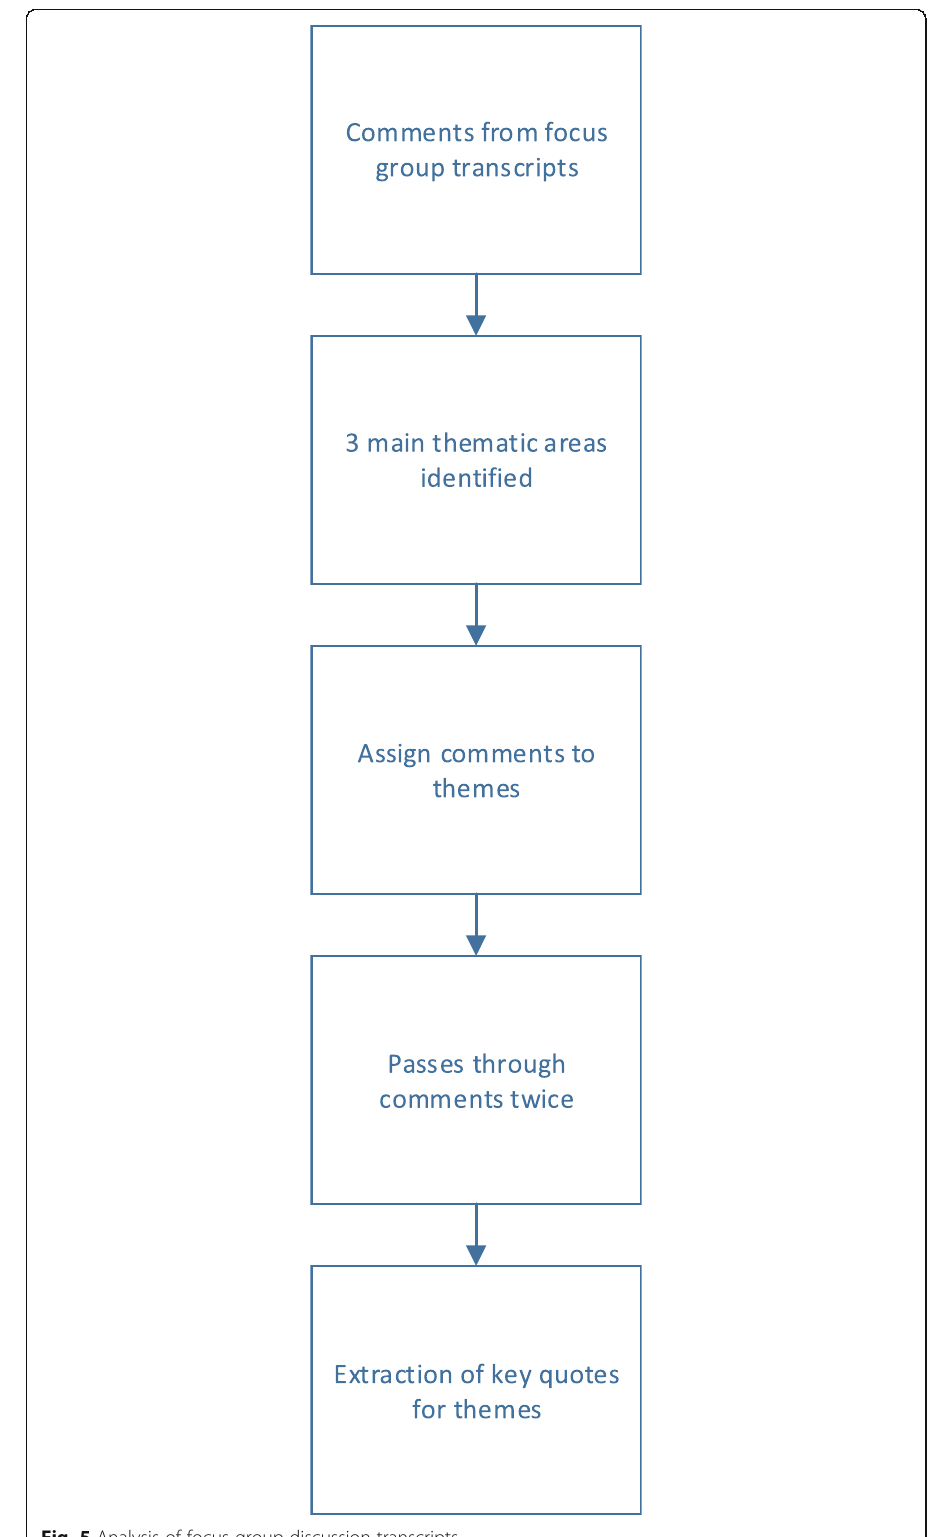
Fig. 5 Analysis of focus group discussion